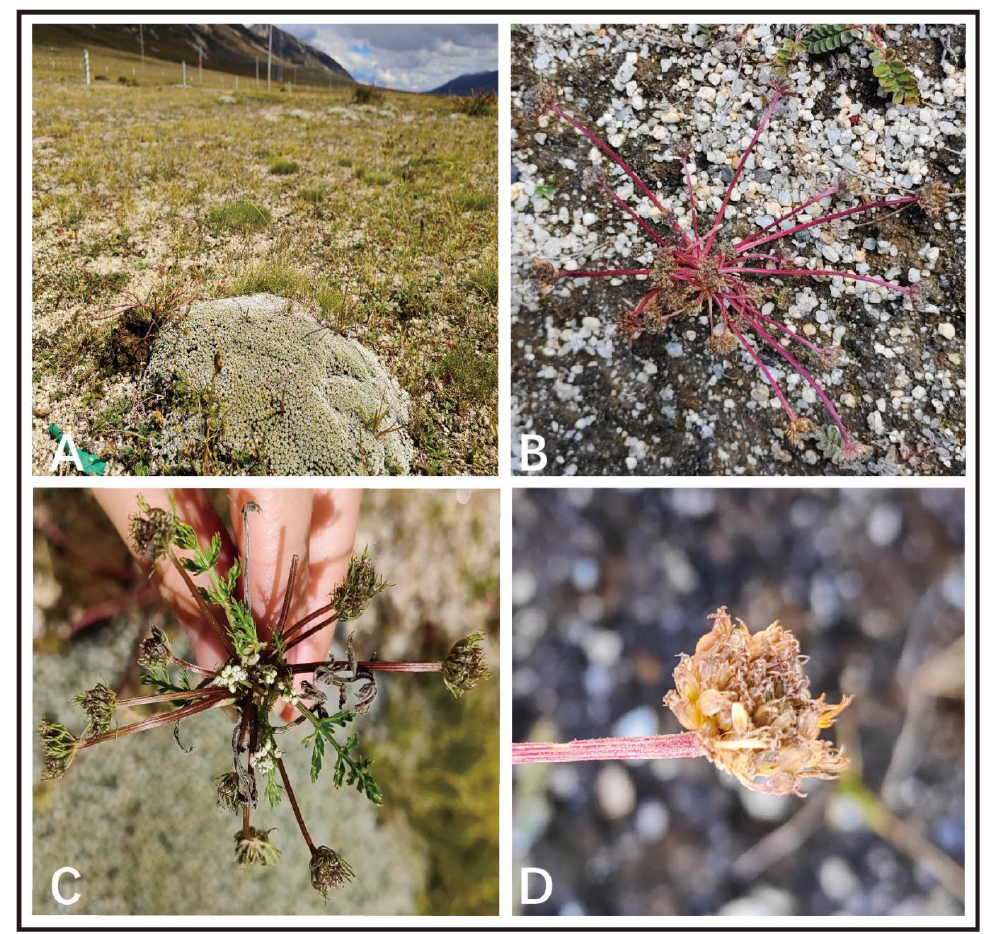
Figure 1. Habitat and morphological features of Ligusticopsis litangensis ( A ) habitat; ( B , C ) plant; ( D ) fruit.